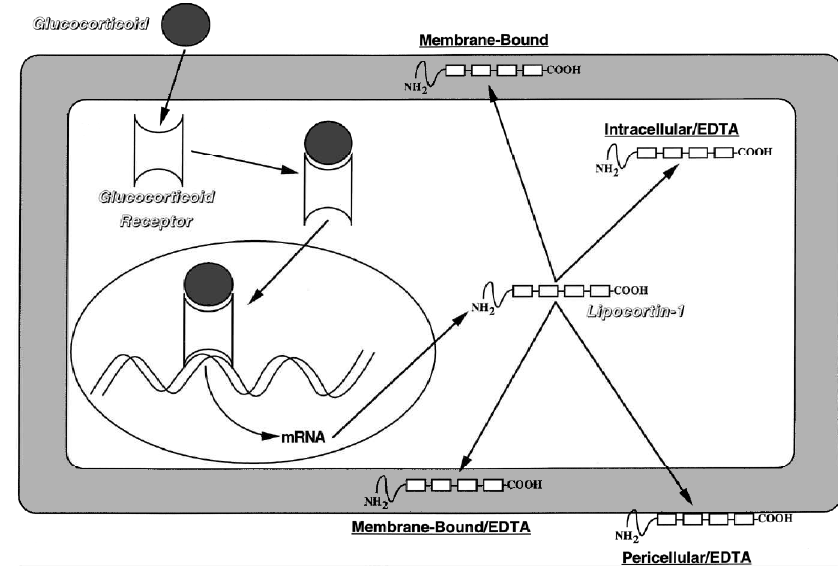
FIG. 2. Cellular distribution of distinct compartments of lipocortin